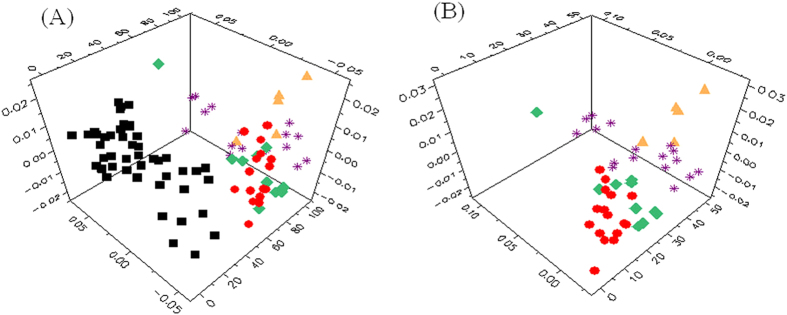
PCA scores plots obtained from NMR data of CRC tumor tissues at different stages (I–IV) with (A) or without (B) ANIT. ANIT (), stage I (), stage II (), stage III (), and stage IV ().